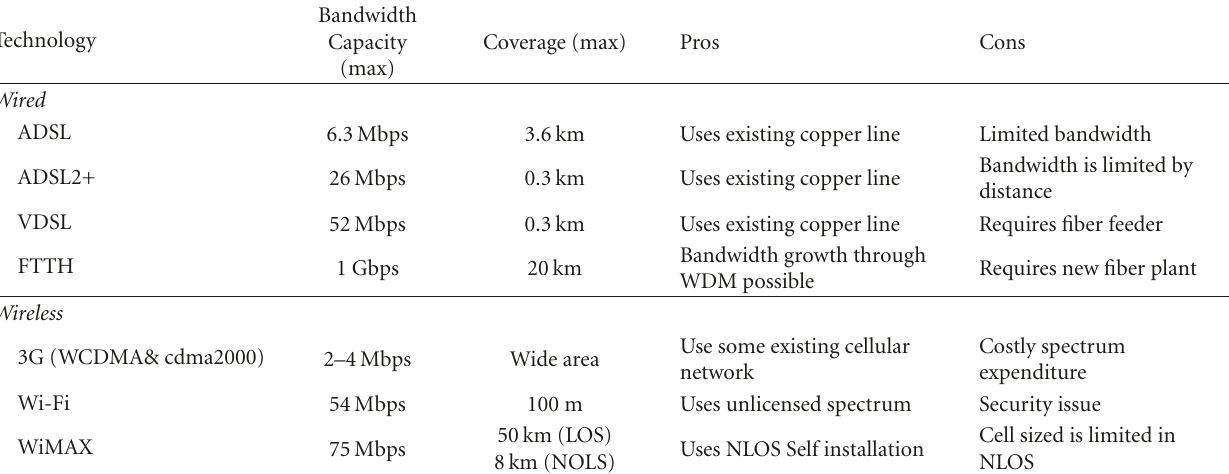
Table 1: Comparison of alternative broadband access